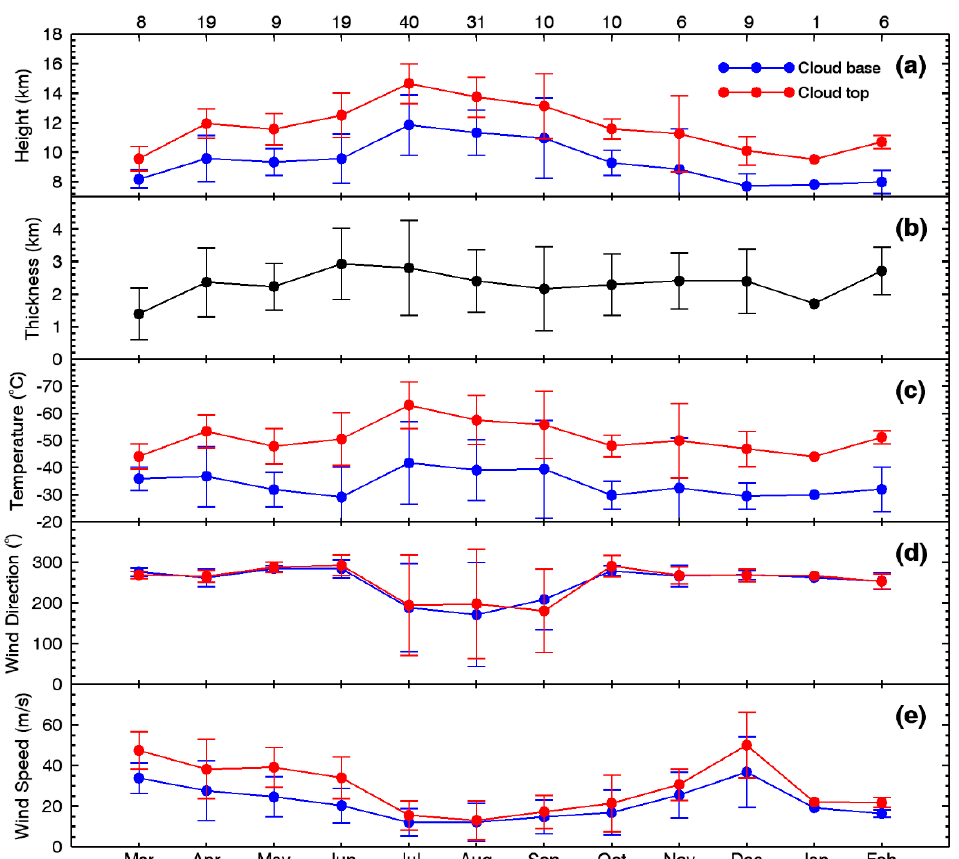
Figure 3. Seasonal variations of ( a ) monthly-mean cirrus top (red) and base (blue) heights, ( b ) monthly-mean geometrical thickness of cirrus clouds, ( c ) corresponding mean temperatures at cirrus top (red) and base (blue) heights, ( d ) monthly-mean wind direction and ( e ) wind speed magnitude at the two heights. The integers shown on the Figure’s top denote respectively cirrus- cloud occurrence number in each month. Note that the cirrus top/base heights maximize in slightly-shifted summer months (from July to September) where the southwesterly wind prevailed, while the cirrus heights minimize in winter months (from December to February).